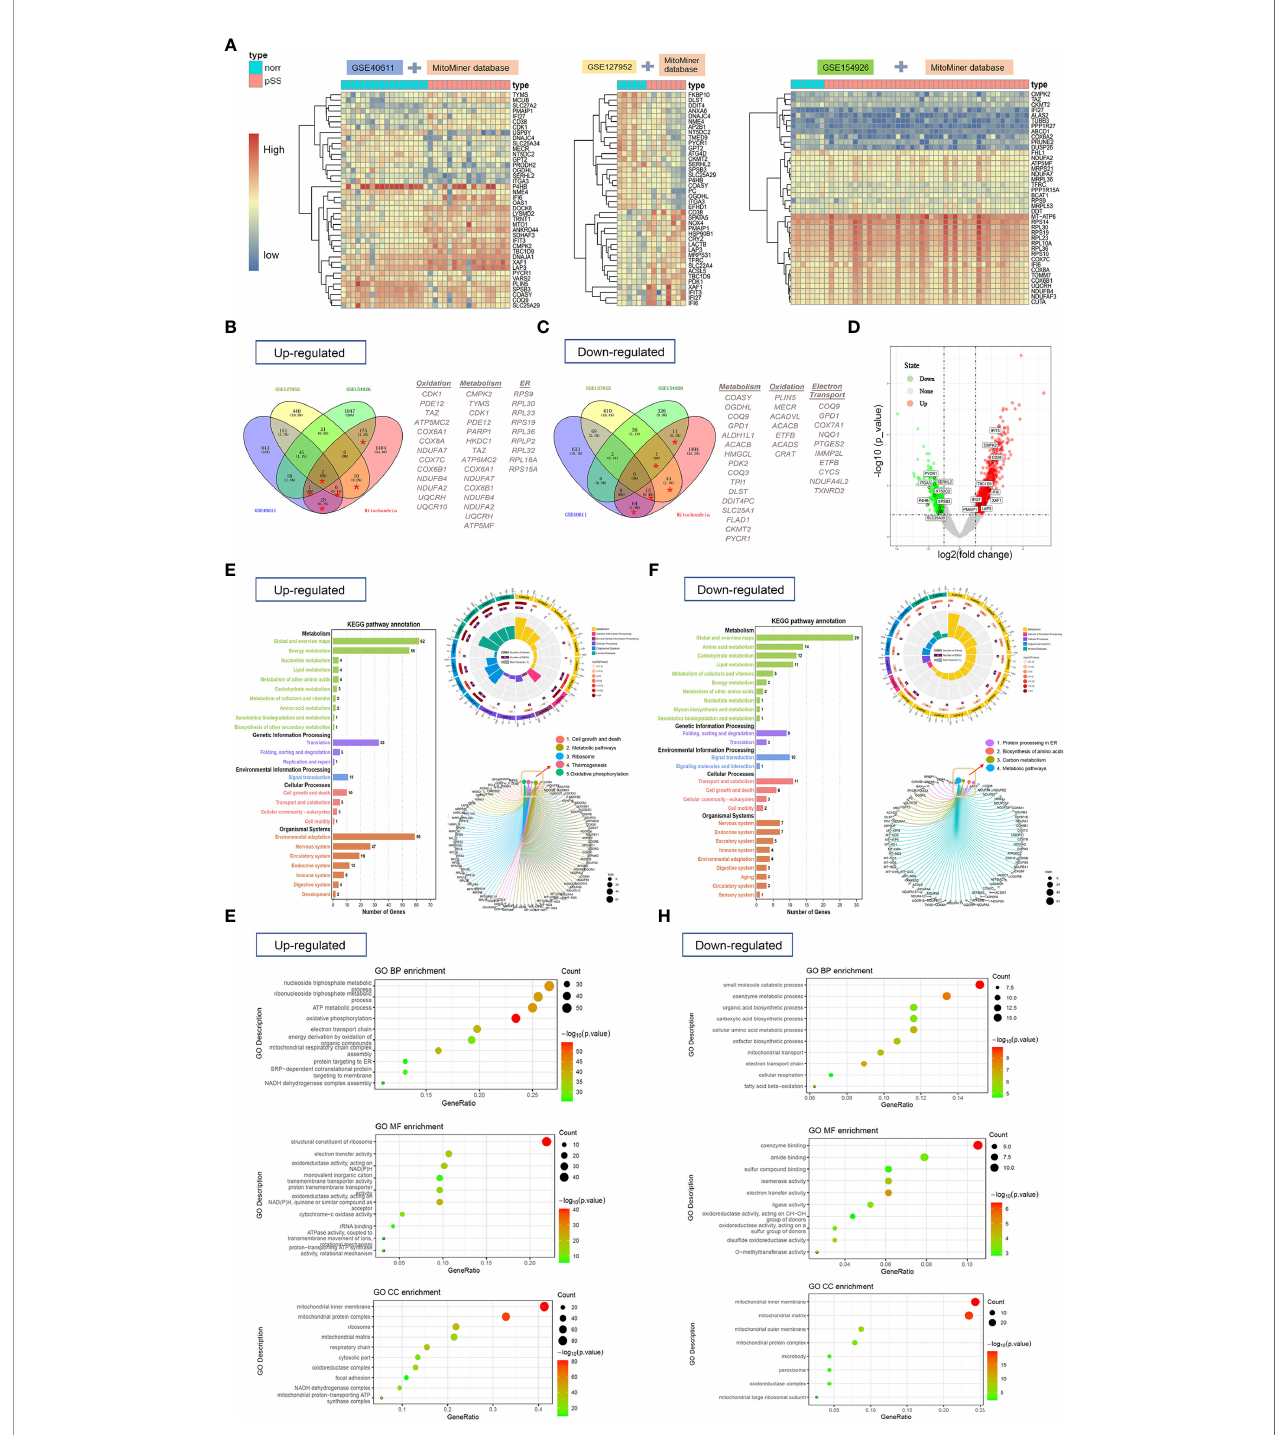
FIGURE 2 | The heat maps, Venn diagram, and volcano plot of mitochondria-related-DEGs and gene-set enrichment analysis (NCBI-GEO database). (A) The heat maps showed overlapping DEGs based on the MitoMiner database which were extracted from 3 publicly available GEO datasets by unsupervised hierarchical clustering within three groups. R-package heatmap was used for fi gure generation. (B, C) Venn diagrams showed the number of upregulated (B) and downregulated DEGs (C) for each dataset and the number of genes that overlap between them. (D) Volcano plot showed mitochondria-related DEGs ( ≥ 2 times of intersection) between pSS and controls. (E, F) The KEGG pathway analyses of upregulated (E) and downregulated DEGs (F) were performed with R package clusterPro fi ler and GSEA based on MSigDB C2-curated KEGG gene sets. (G, H) GO analysis of upregulated (G) and downregulated (H) mitochondria-related DEGs was performed to identify enriched biological process including molecular function, cell component, and